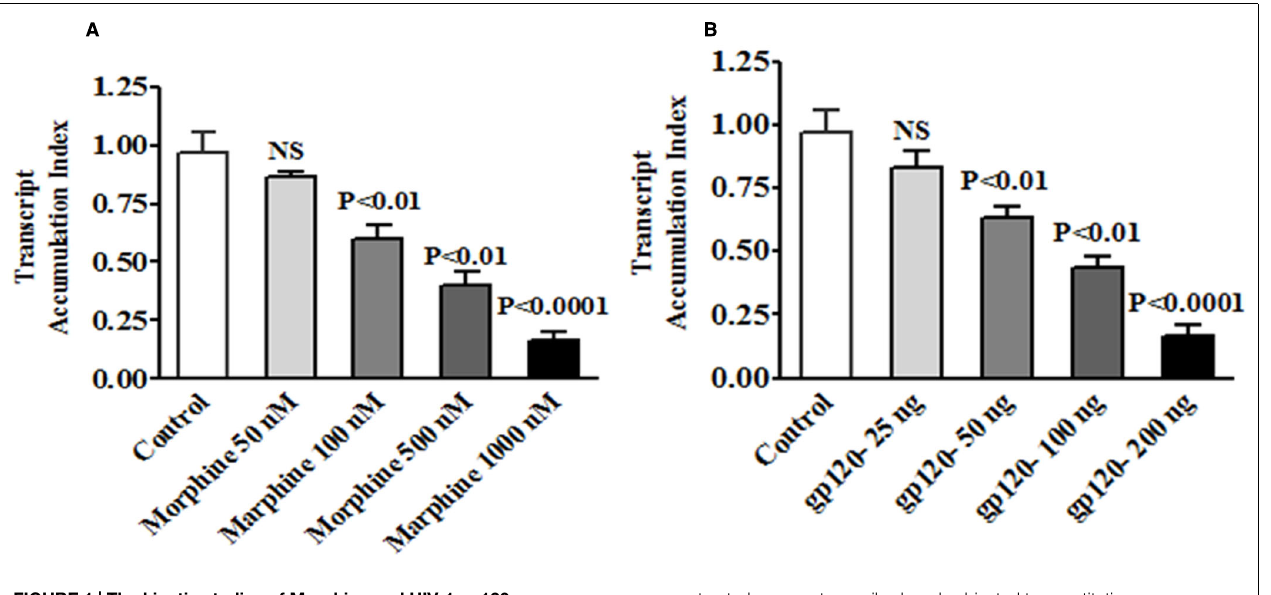
FIGURE 1 | The kinetic studies of Morphine and HIV-1 gp120 protein impact redox dysfunction in GSS gene expression. Microglia (1 (cid:2) 10 6 cells/ml) were treated with (A) morphine (0–1000 nM) and (B) HIV-1 gp120 (0–200 ng) for 24 h for dose response studies. RNA